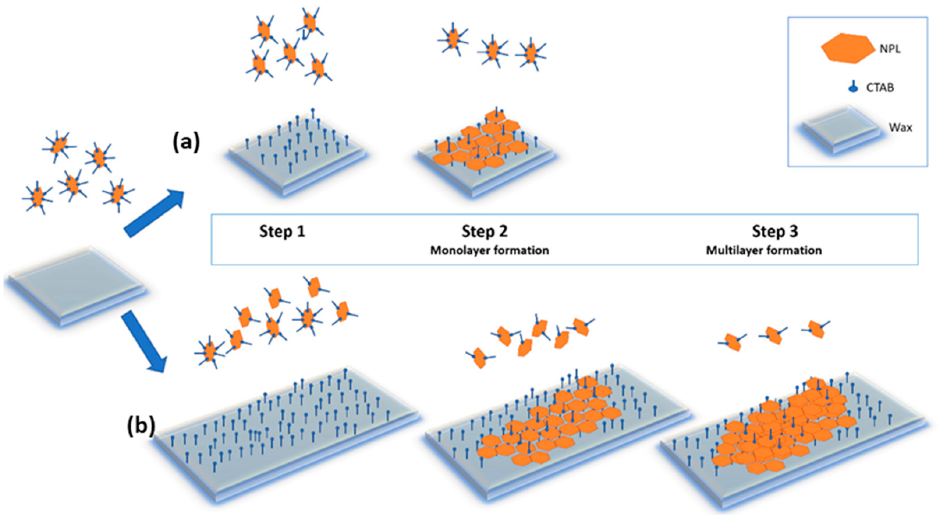
Figure 7. ( a ) SEM image of Sample 9 with ( b ) the magnification of ( a ) with arrows pointing at the aggregates of NPLs-Si in areas circled in